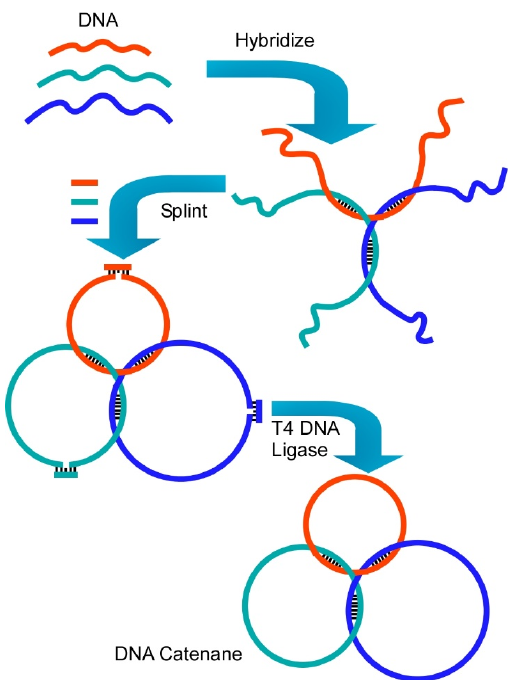
Figure 21. DNA Programmable nanoarchitectonics with DNA components to form advanced supramolecular structures such as interlocked structure, catenane. Molecules 2021 , 26 , x FOR PEER REVIEW